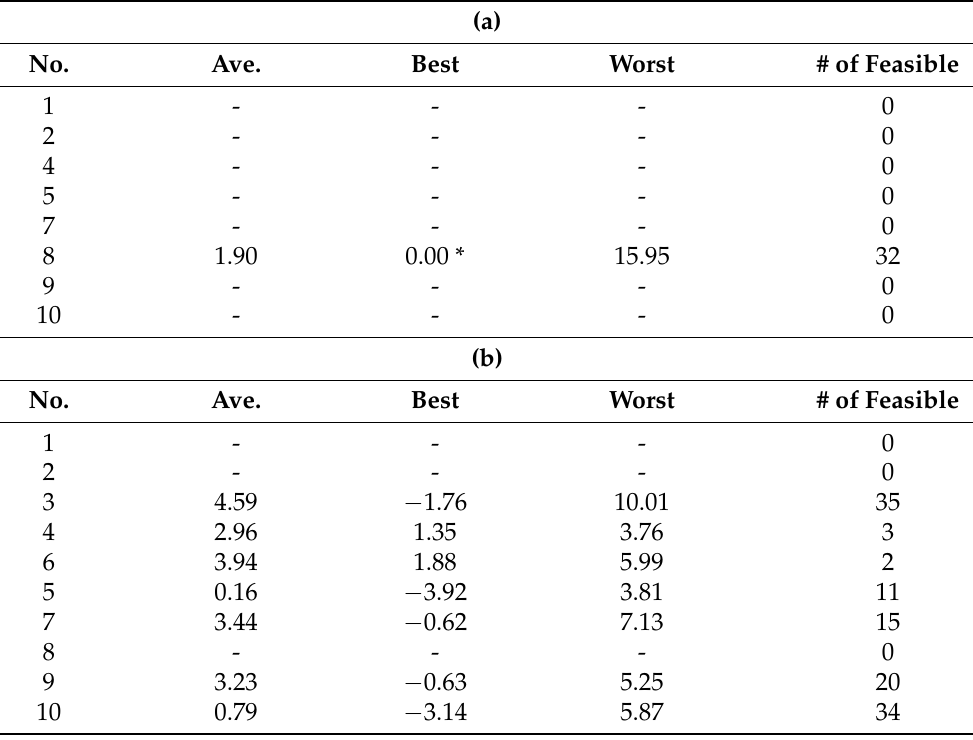
Table 4. Results of exploring feasible solution space for solving the mBSSRP. Ave., Best and Worst represent the average, best and worst gaps calculated using Equation (24). Symbol “-” means that no feasible solutions can be obtained. The feasible solutions of the instances 3 and 6 ( n = 30) cannot be found using the latest version of the Gurobi optimizer 9.1.1. For n = 50, negative values of the best gaps mean that the method can find better solutions than that found by the Gurobi optimizer 9.1.1 within 12 h. Symbol “*” means that an optimal solution can be obtained using the Gurobi